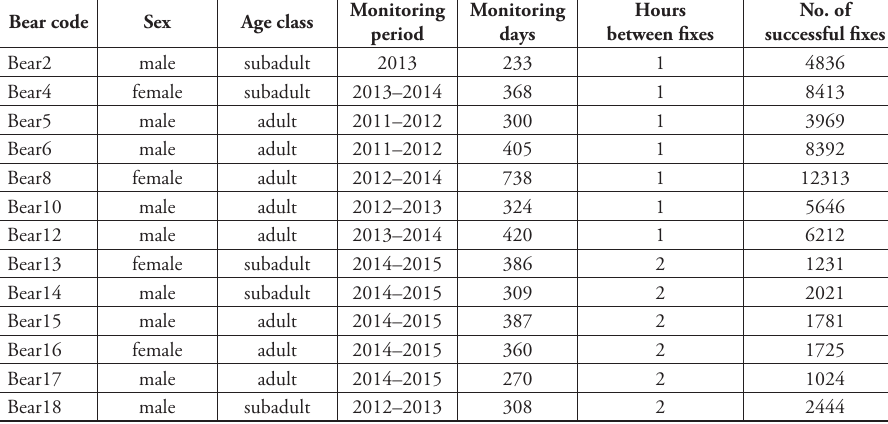
Table 1. GPS collared brown bears in Eastern Romanian Carpathians and